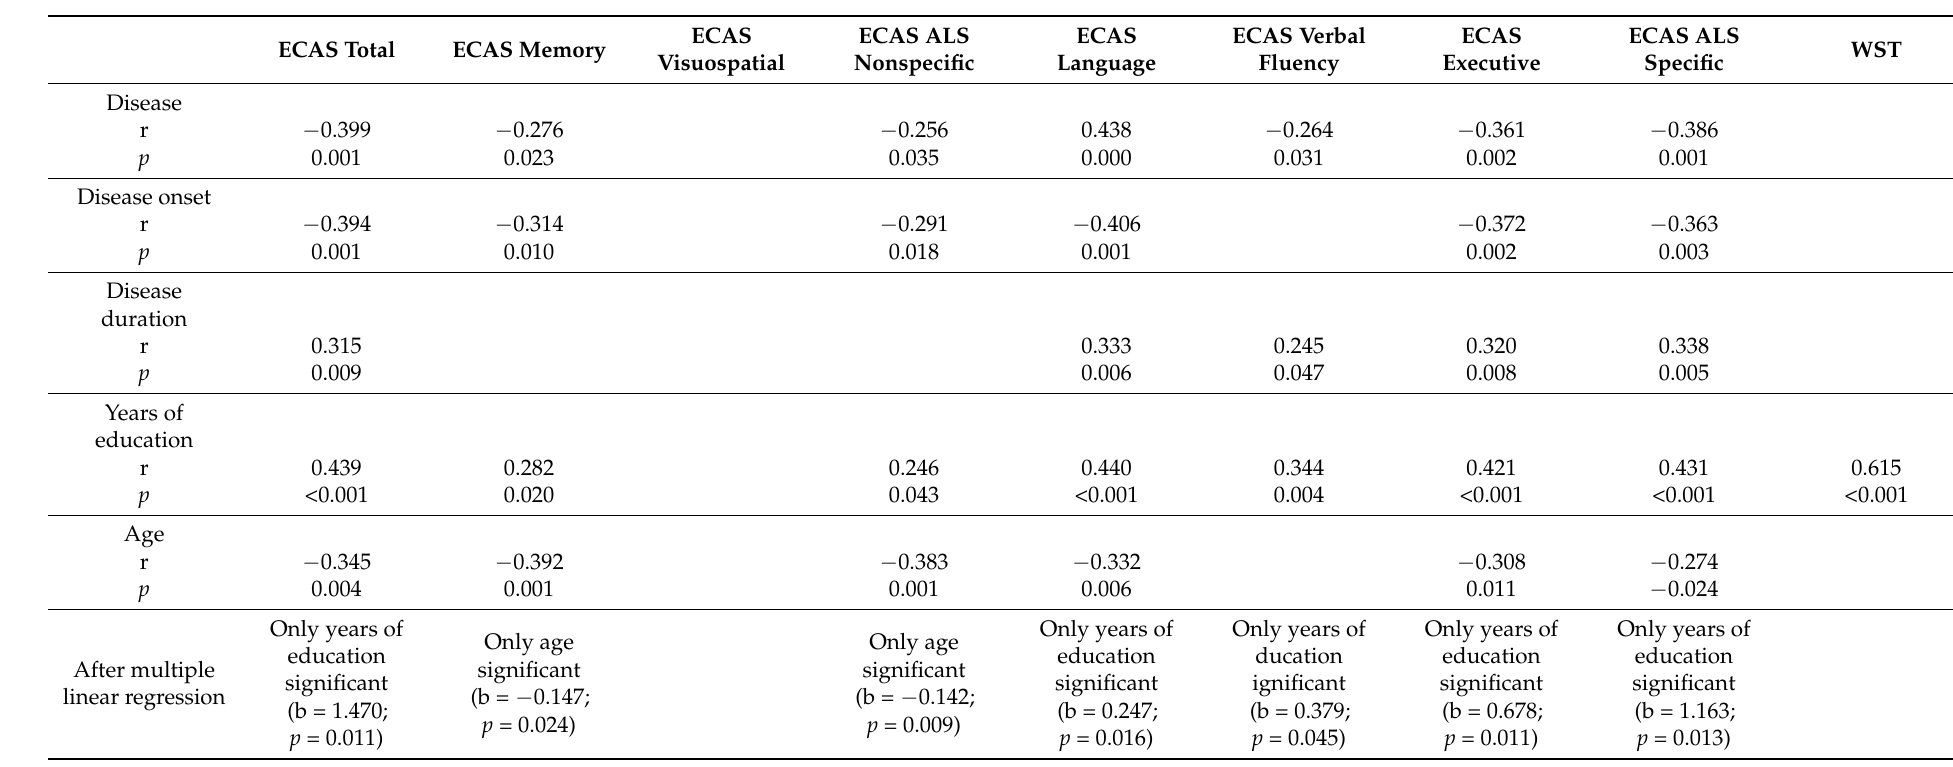
Table 3. Results of multiple linear regression analysis and influencing factors on cognitive test performance. Disease (SMA or ALS), disease onset, disease duration, years of education and age were identified as the factors that had an influence on the different cognitive tests/domains. However, after using multiple linear regression, it emerged that only years of education and age at testing showed a significant correlation with test performance. Only significant scores are shown for better overview. Abbreviations: ECAS, Edinburgh Cognitive and Behavioural ALS Screen; WST,